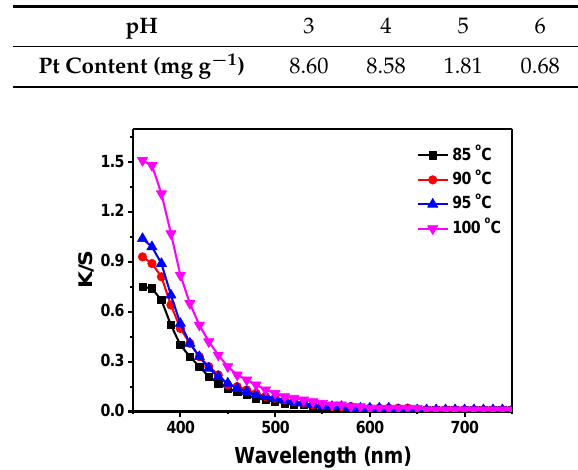
Figure 6. K/S curves of the silk fabric treated at different temperatures with 0.3 mM of H 2 PtCl 6 .